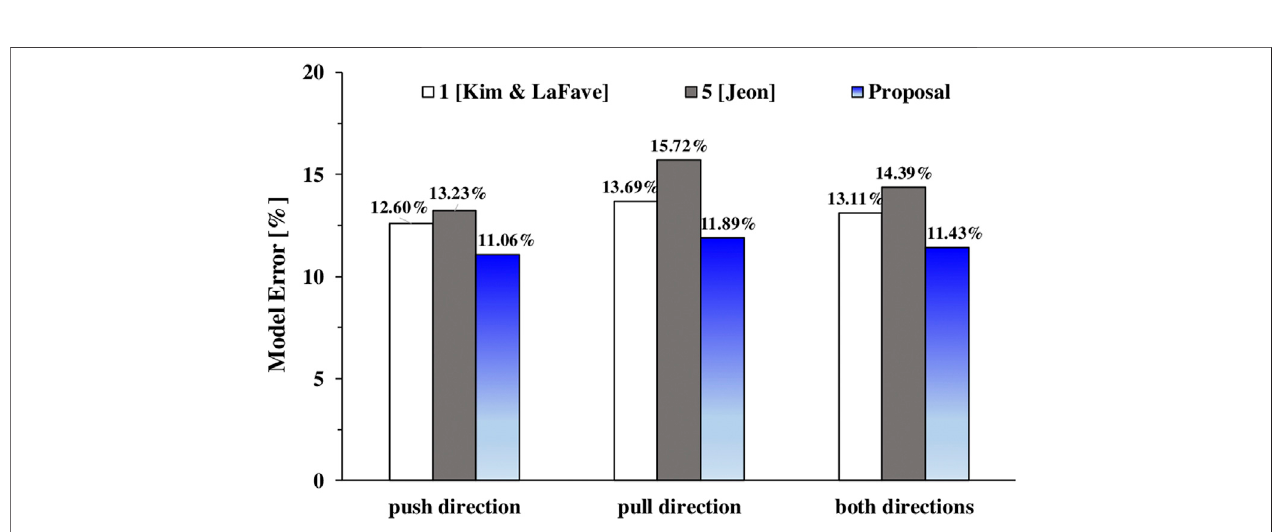
FIGURE 6 | Comparisons between the new proposal and Models 1 & 5 in terms of mean errors calculated according to MAPE on all the considered experimental tests.